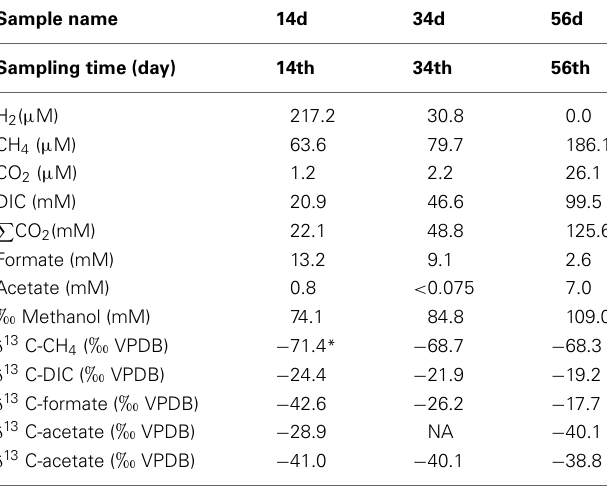
Table 5 | Geochemical data of samples 14d, 34d, and